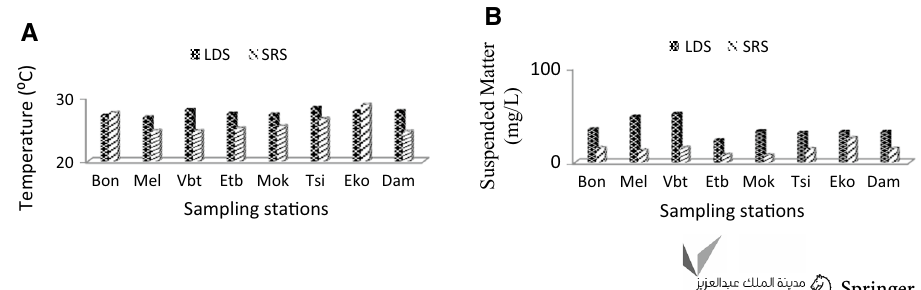
Fig. 1 Spatiotemporal variation of the temperatures ( a ) and suspended matter ( b )